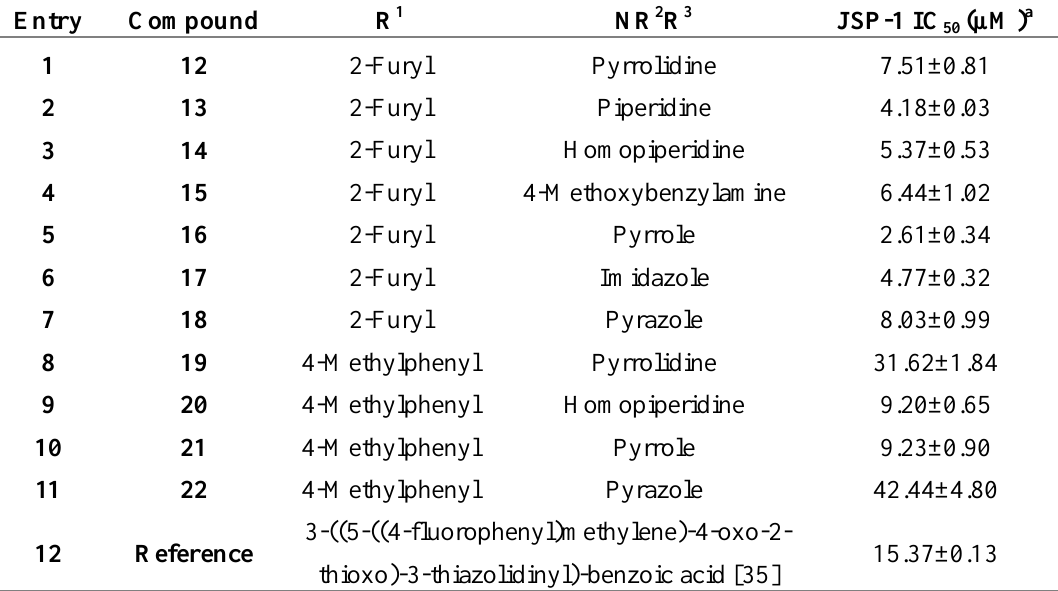
Table 3. JSP-1 inhibiting activities of 6-aminoquinoxalines 12 -